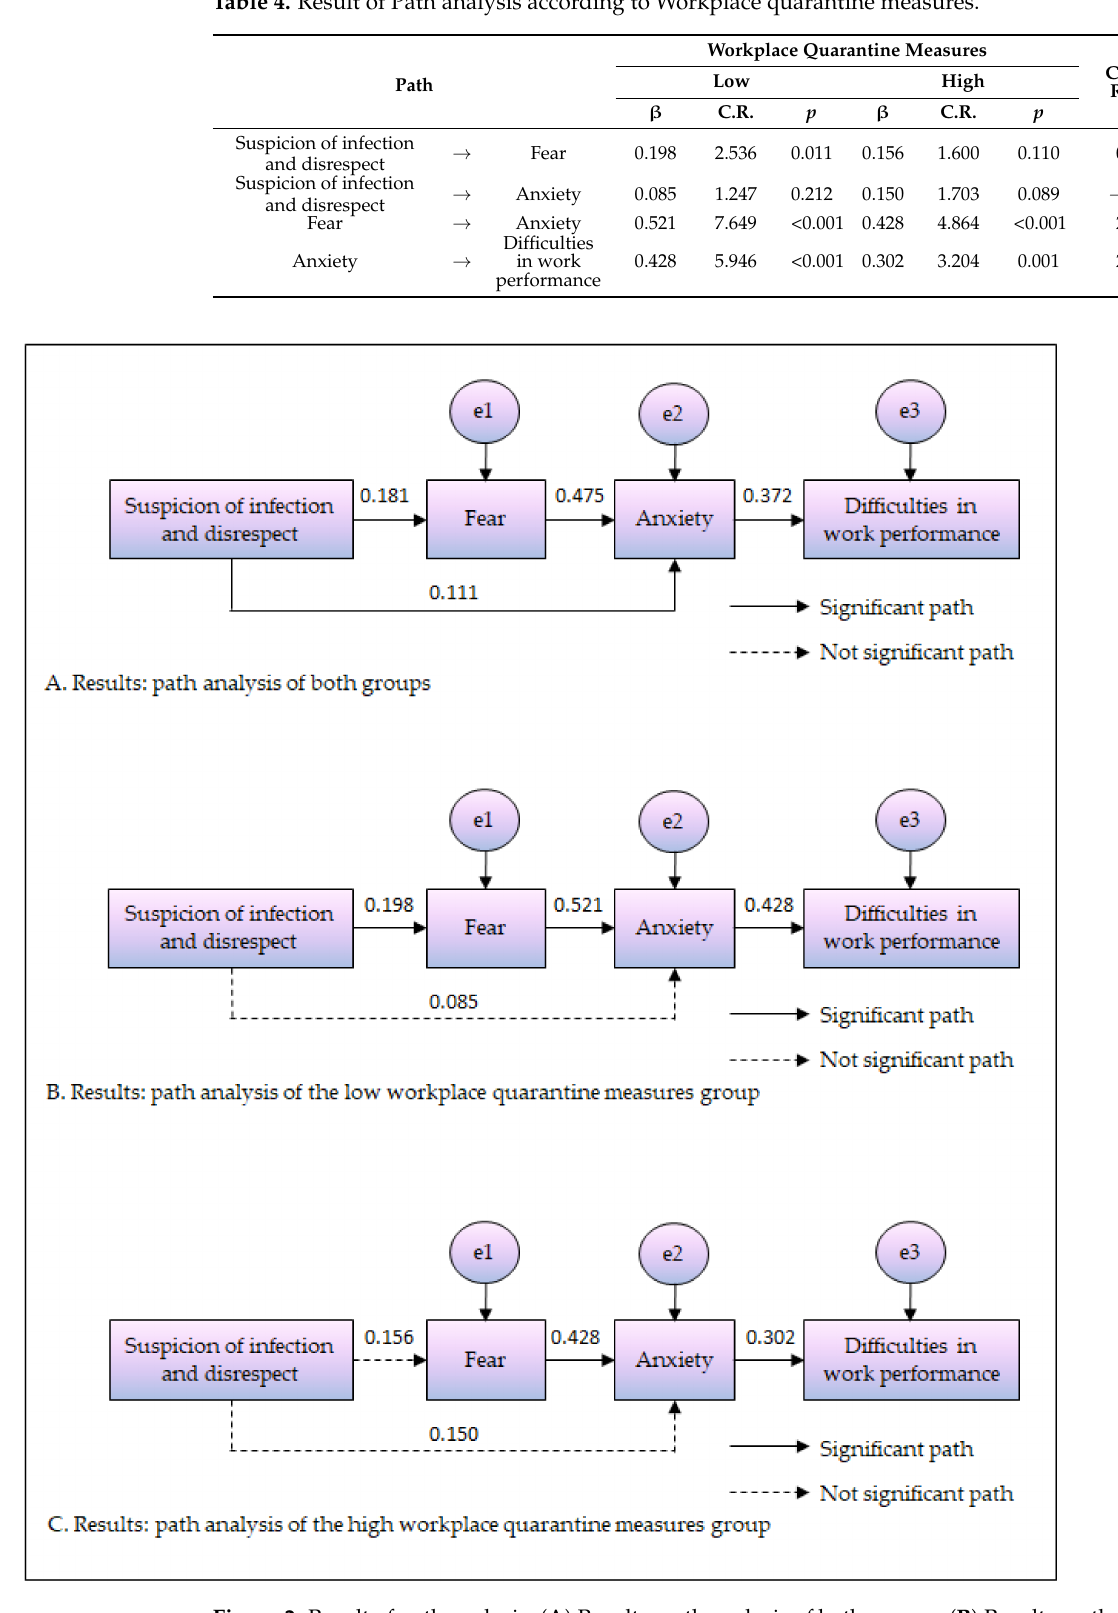
Figure 2. Result of path analysis. ( A ) Results: path analysis of both groups. ( B ) Results: path analysis of the low workplace quarantine measures qroup. ( C ) Results: path analysis of the high workplace quarantine measures